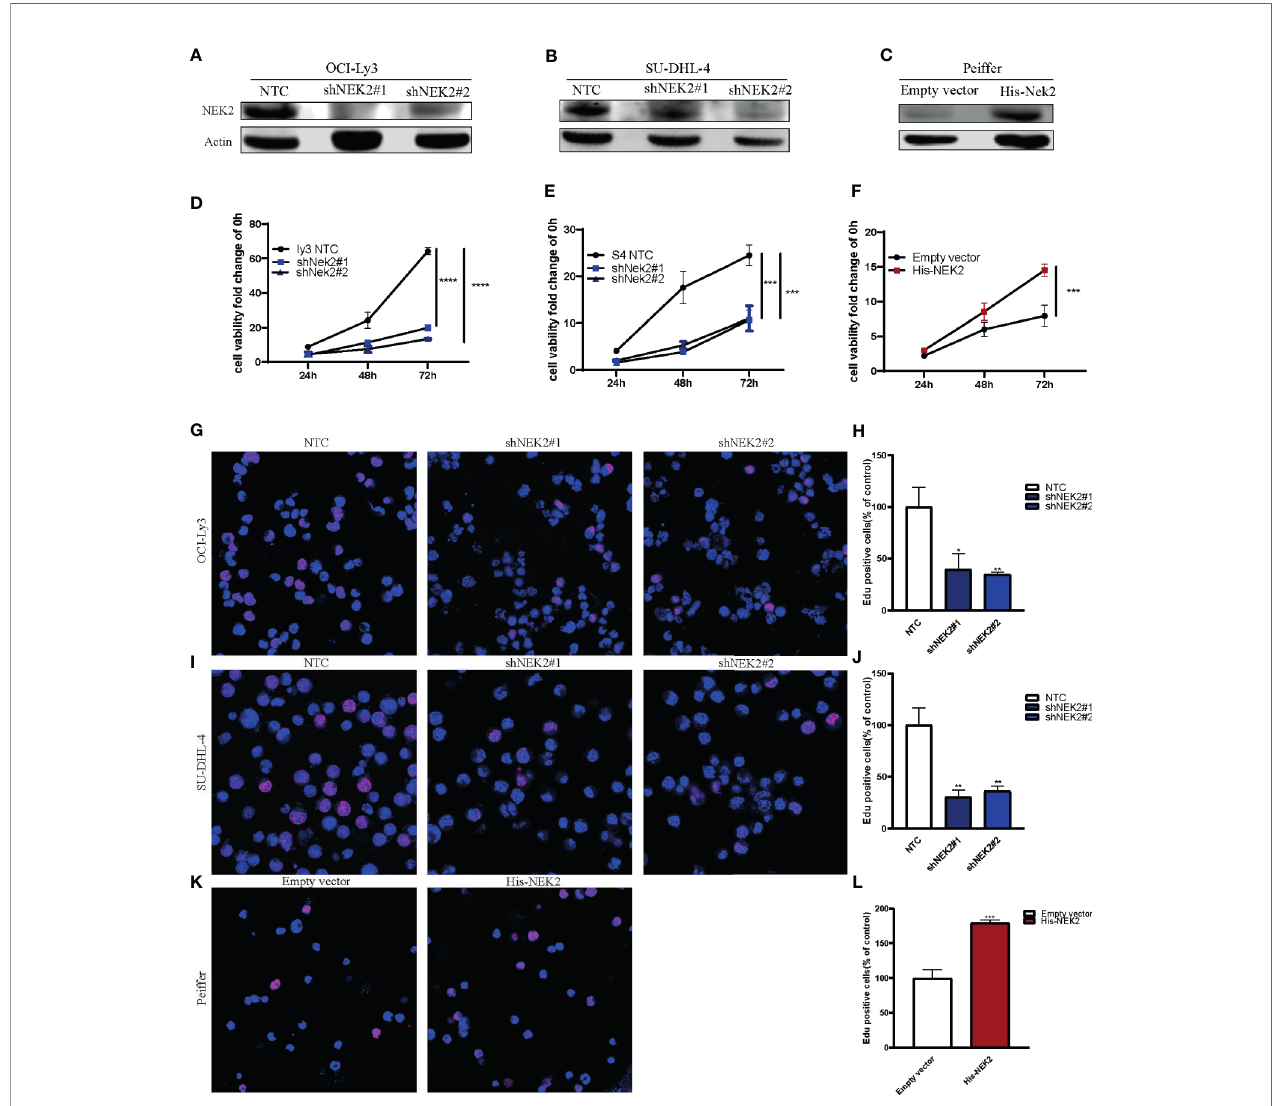
FIGURE 2 | NEK2 promotes cell proliferation and inhibits apoptosis. (A, B) Two different shNEK2 sequences were used (#1 and #2). Western blotting con fi rmed the NEK2 was ef fi ciently knocked down in OCI-Ly3 and SU-DHL-4 cells; (C) Peiffer was infected by NEK2-overexpressing lentivirus. Western blotting showed successful over-expression of NEK2 in Peiffer cells; (D – F) NEK2 increased cell viability as re fl ected by CCK-8 proliferation assay (****P < 0.0001, ***P < 0.001, Student ’ s t-test); (G – L) Representative images of EdU staining and histogram statistics of Edu-positive cell rate, which also re fl ected NEK2 increased cell proliferation (*P < 0.05, **P < 0.01, ***P < 0.001, Student ’ s